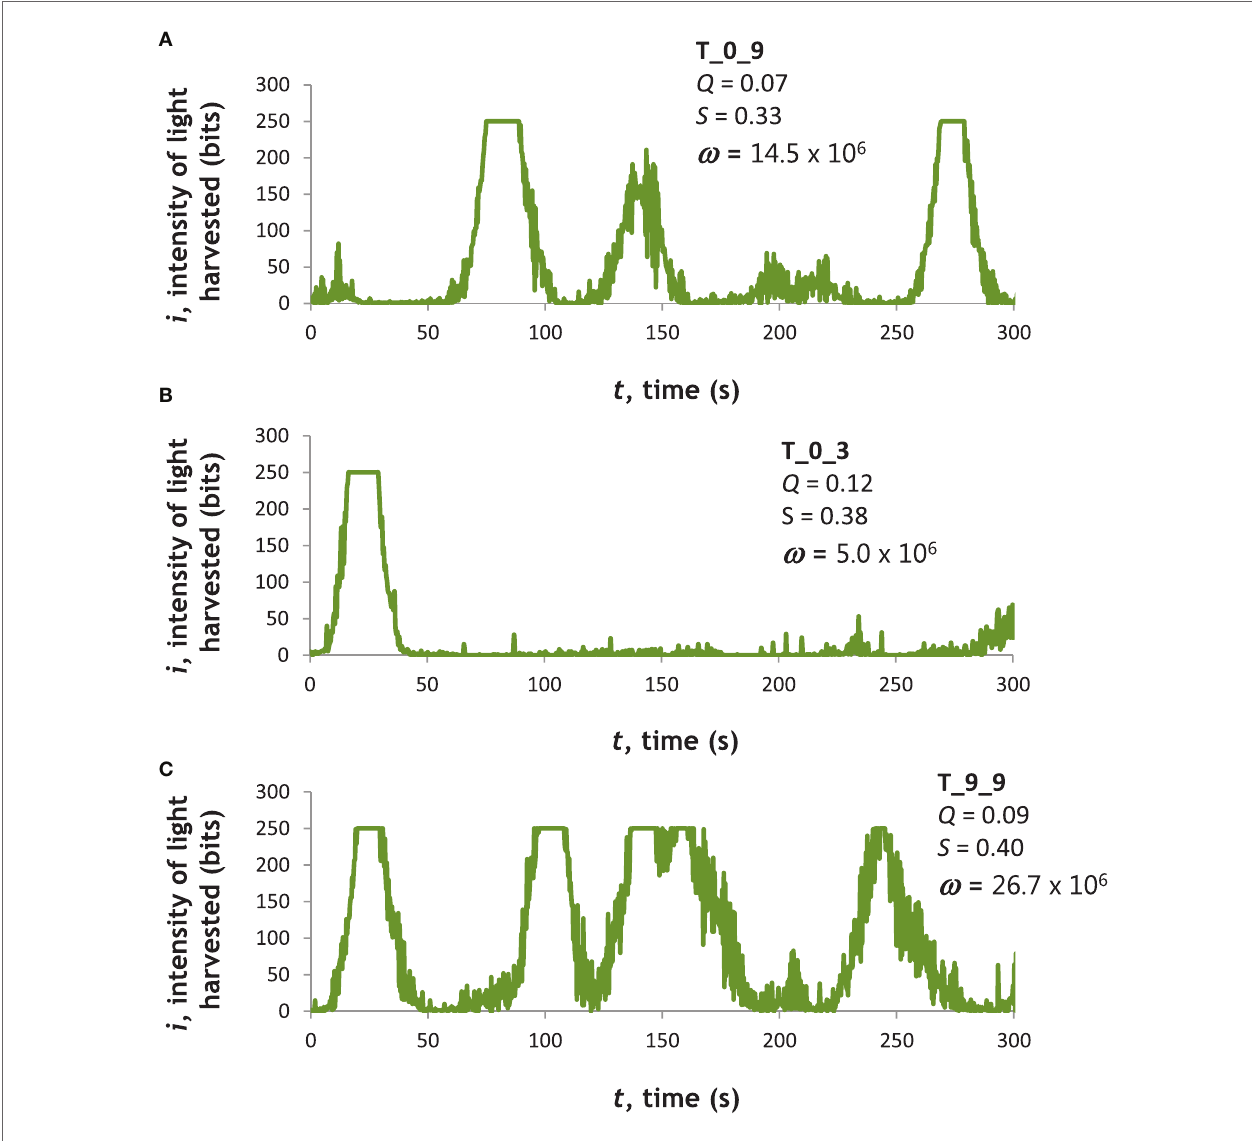
FigUre 4 | light-harvesting performance varied among Tadros . Examples of three different ANNs, two (a,B) from the first generation of randomly generated ANNs (T_0_9 and T_0_3) and one (c) from the final generation (T_9_9). Naming convention: T, Tadro; first digit, generation; and second digit, rank order of individual based on fitness on ascending scale. These examples were chosen to highlight variance in the first generation and then the best individual in the last generation. Moreover, T_0_9 had the highest fitness in generation 0 and produced more descendants, including T_9_9, than any other genotype. T_0_3 had an intermediate fitness in generation 0 but produced no offspring and was selected as an example of an evolutionary dead